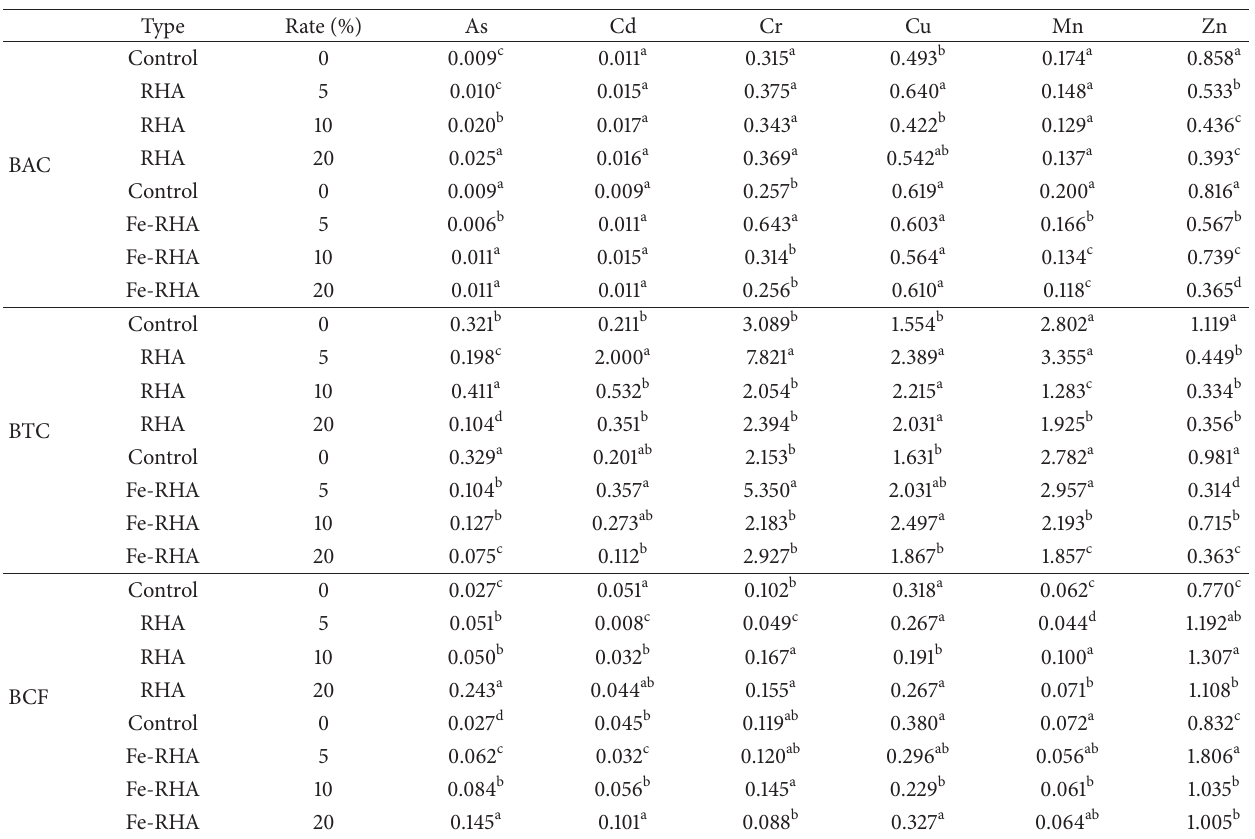
Table 5: Biological accumulation coefficient (BAC), biological transfer coefficient (BTC), and bioconcentration factor (BCF) of heavy metals by vetiver grass grown in the gold mine tailings amended with Fe-RHA and RHA (mean 𝑛 = 3 ). Different letters correspond to significant differences between rates of the same ash ( 𝑃 < 0.05) in the same